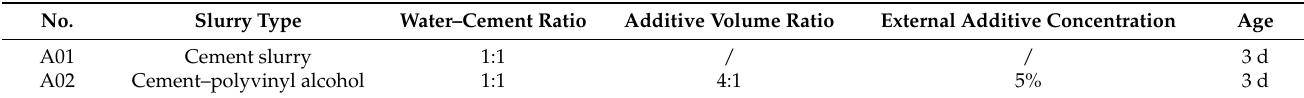
Table 2. Preparation of slurry for electron microscope scanning.